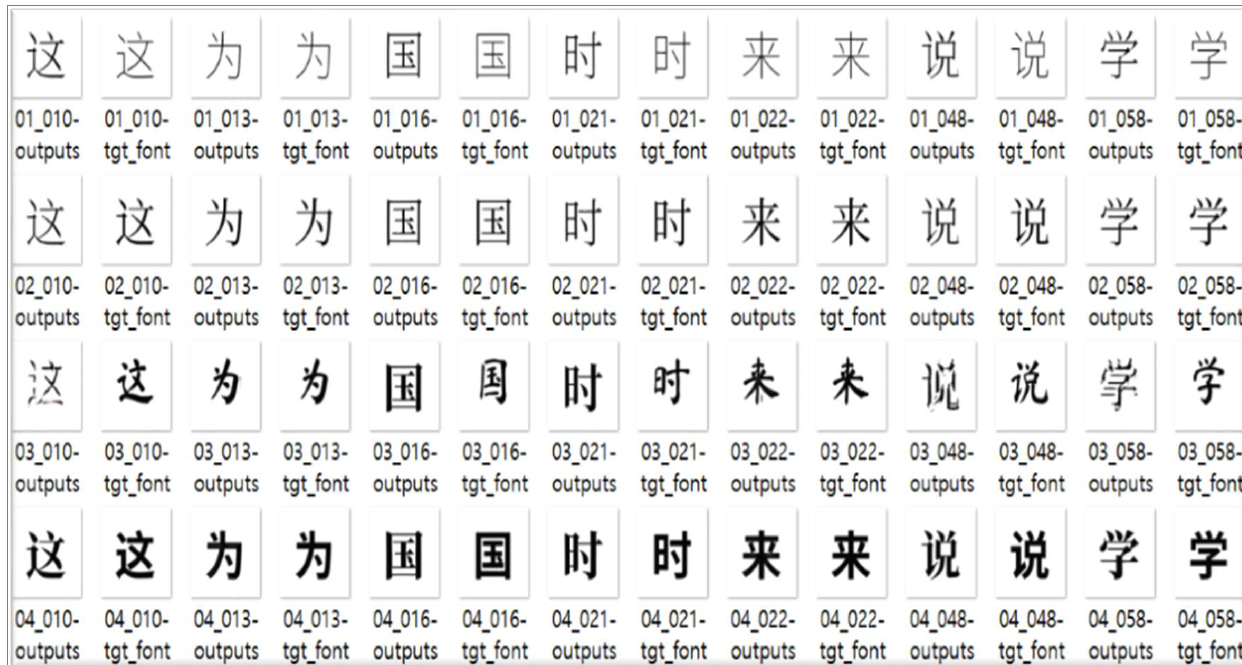
Figure 17. Sample output images of SC characters (left: output, right: target).